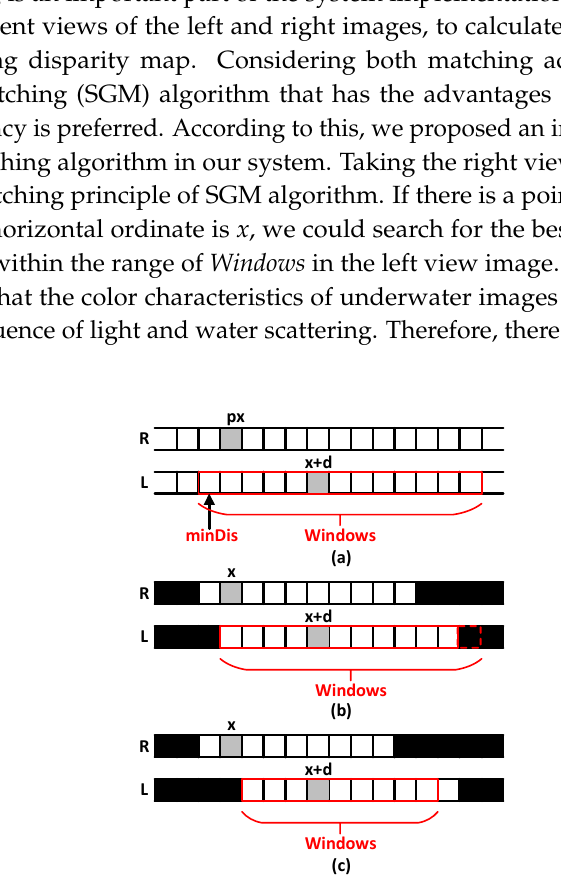
Figure 8. Comparison of disparity calculation. ( a ) The stereo matching principle of SGM algorithm; ( b ) Stereo matching without constraint of the valid target area; ( c ) Stereo matching strictly constrained within the valid target area.